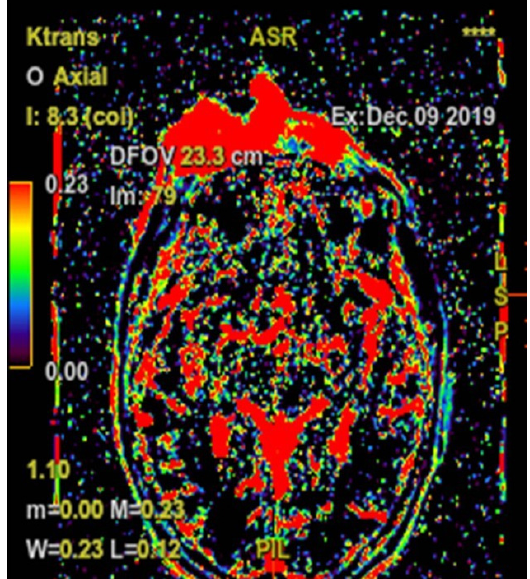
Figure 7. High constant transfer (ktrans) value was observed, pointing to a possible good response for radiochemotherapy.